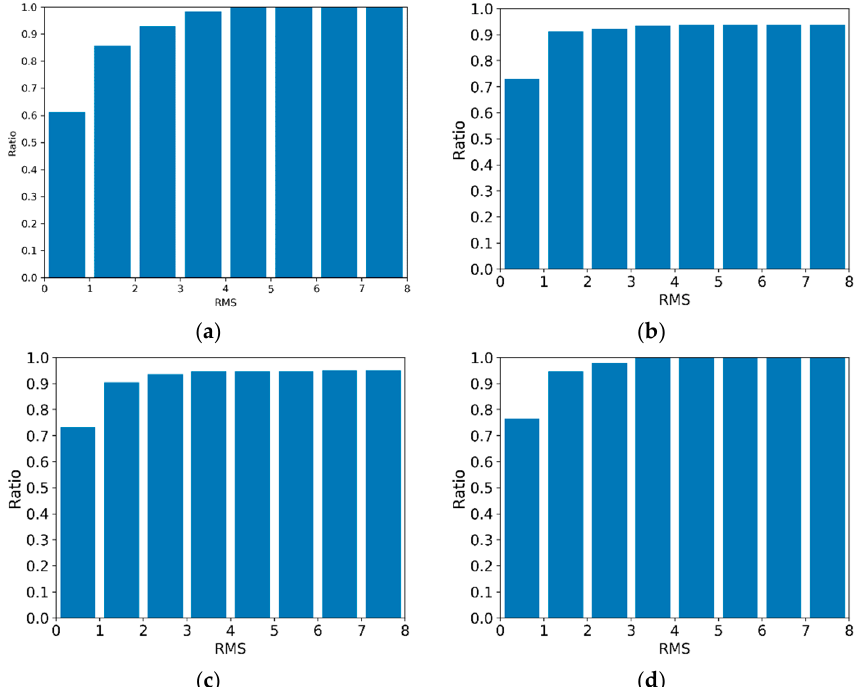
Figure 4. Correct relocation rate of four objects in the offline experiment.